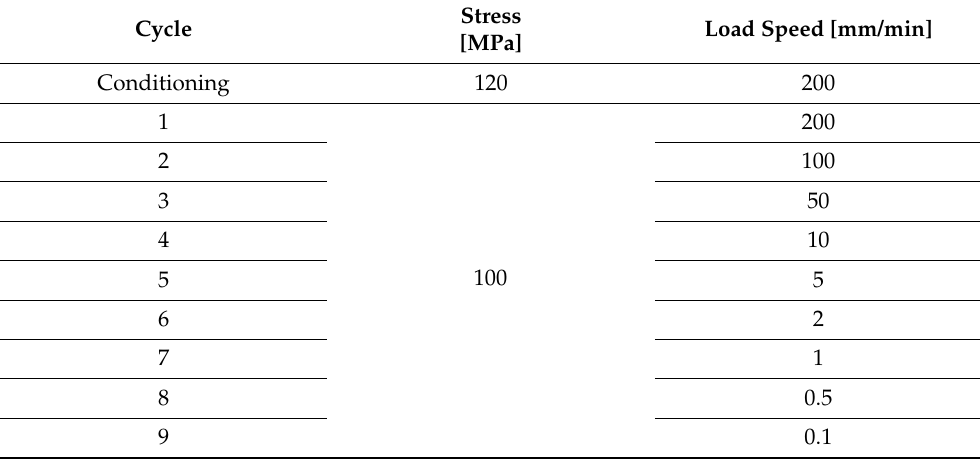
Table 2. Parameters for RRLS